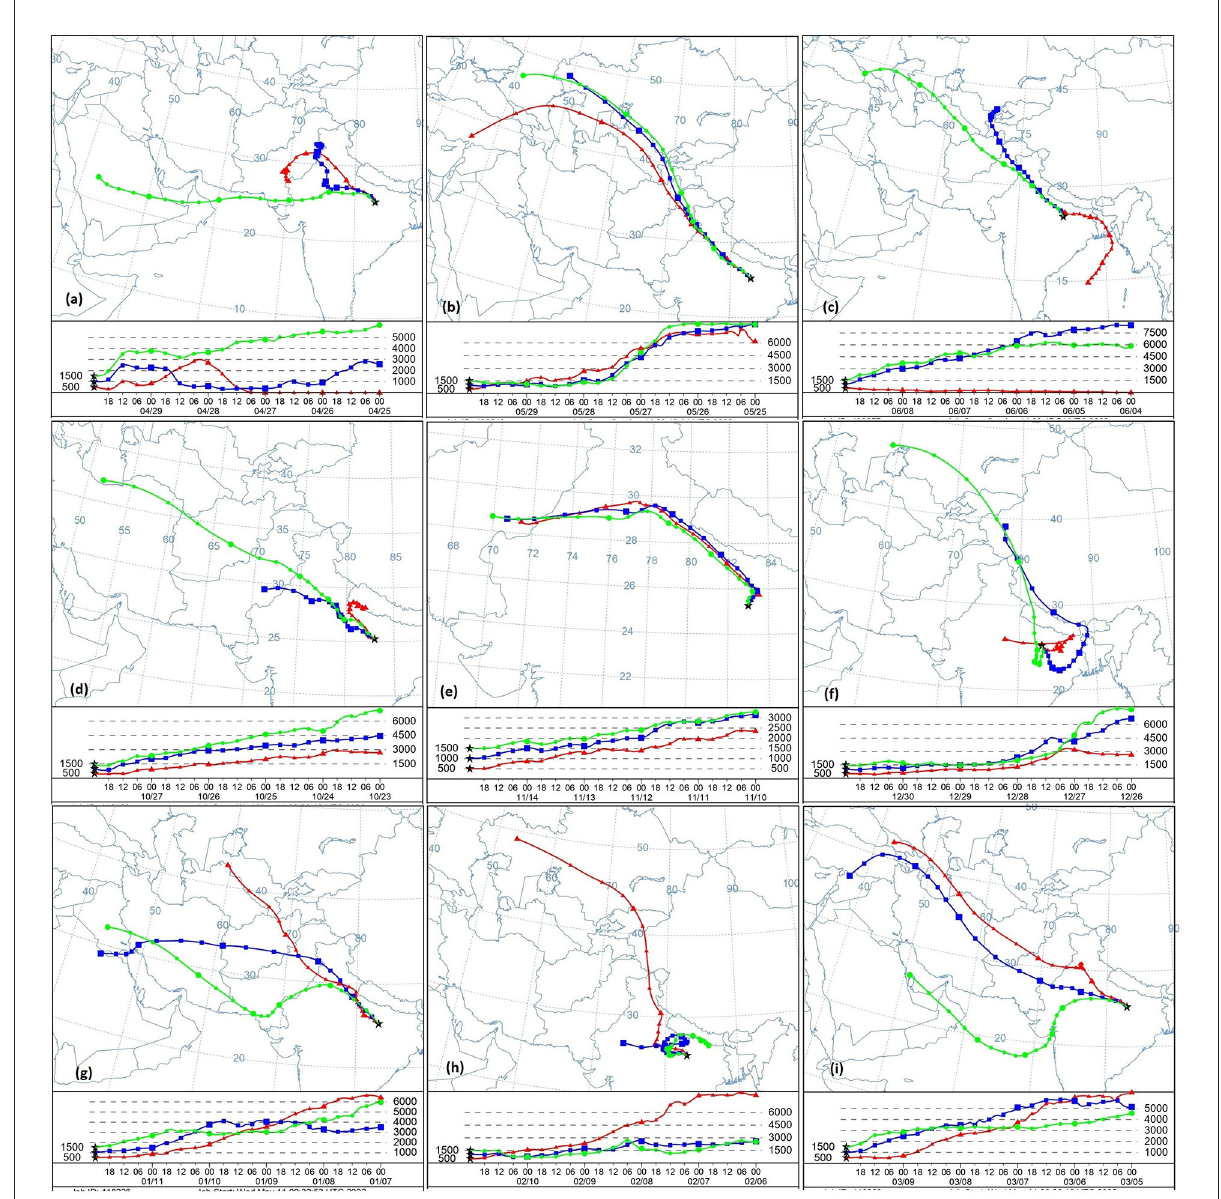
FIGURE12 About 5 days back trajectories derived from HYSPLIT model for Varanasi for nine typical days having large aerosol loading on (a) 30 April 2019, (b) 30 May 2019, (c) 09 June 2019, (d) 28 October 2019, (e) 15 November 2019, (f) 31 December 2019, (g) 12 January 2020, (h) 11